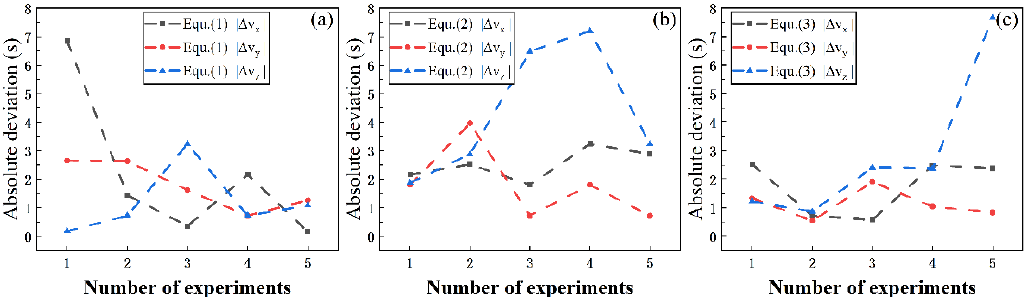
Figure 17. Deviation of rotation angle measured by theodolite and laser tracker relative to photogrammetry: ( a ) corresponds to (1); ( b ) corresponds to (2); ( c ) corresponds to (3).